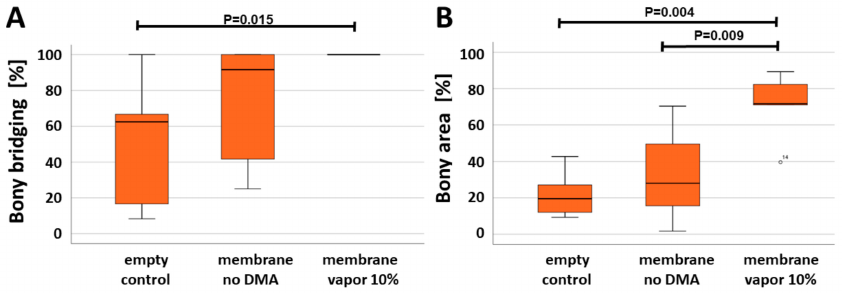
Figure 5. Analysis of bone regeneration parameters. ( A ) Quantification of bony bridging represented as a percentage of the 6 mm defect, ( B ) bony regenerated area as a percentage of pixel numbers identified as bone in the trichrome staining in relation to the entire defect. Empty refers to the defects without any membrane. Membrane no DMA refers to the native PLGA membranes. Membrane vapor 10% refers to the PLGA membranes pre-loaded with 10 wt % DMA via vapor deposition. Values are displayed as box plots ranging from the 25th (lower quartile) to the 75th (upper quartile) percentile, including the median as a solid black line and whiskers showing the minimum and maximum values. In (B) values outside the range of the box plot are shown as individual points. ( p values are